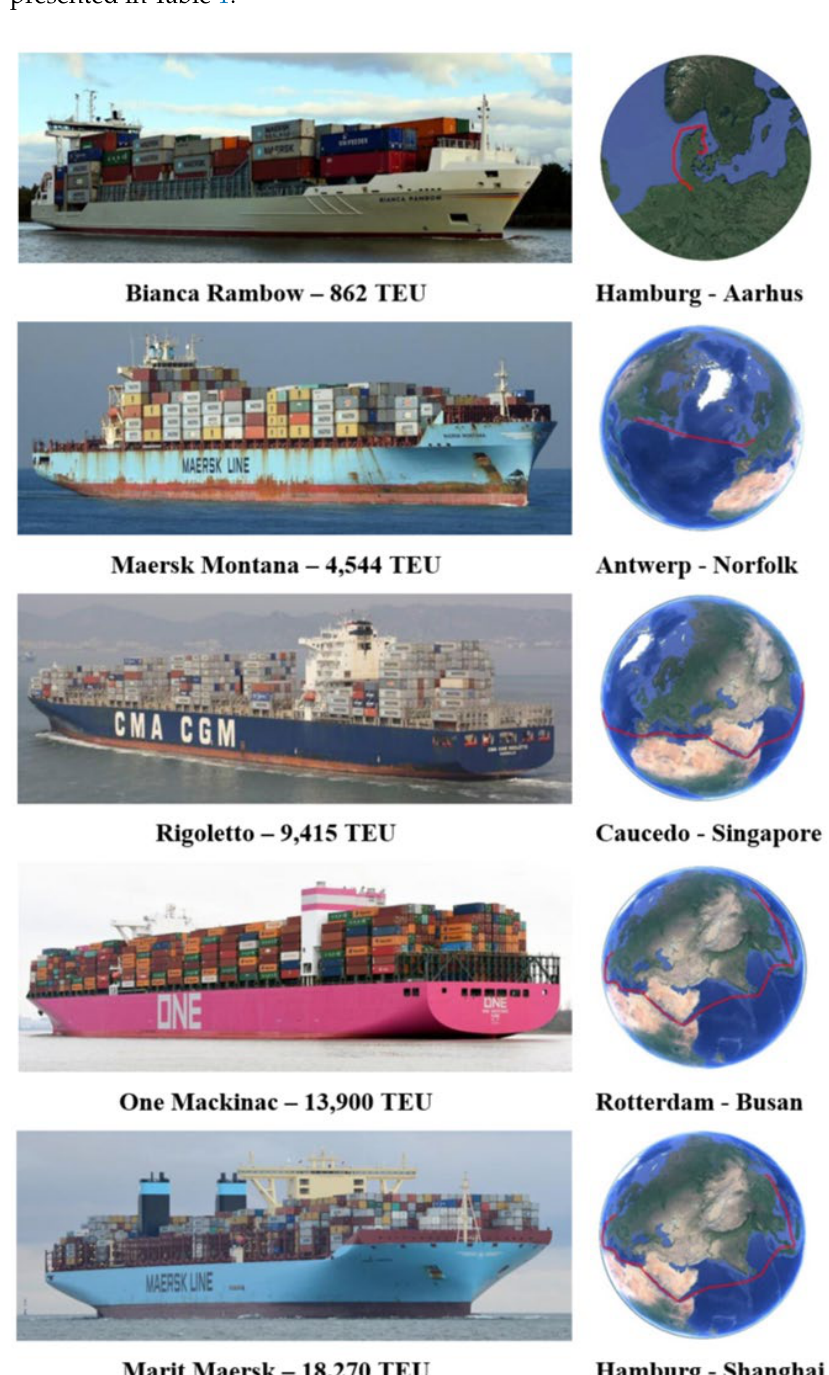
Figure 6. Selected vessels and their shipping routes [70].